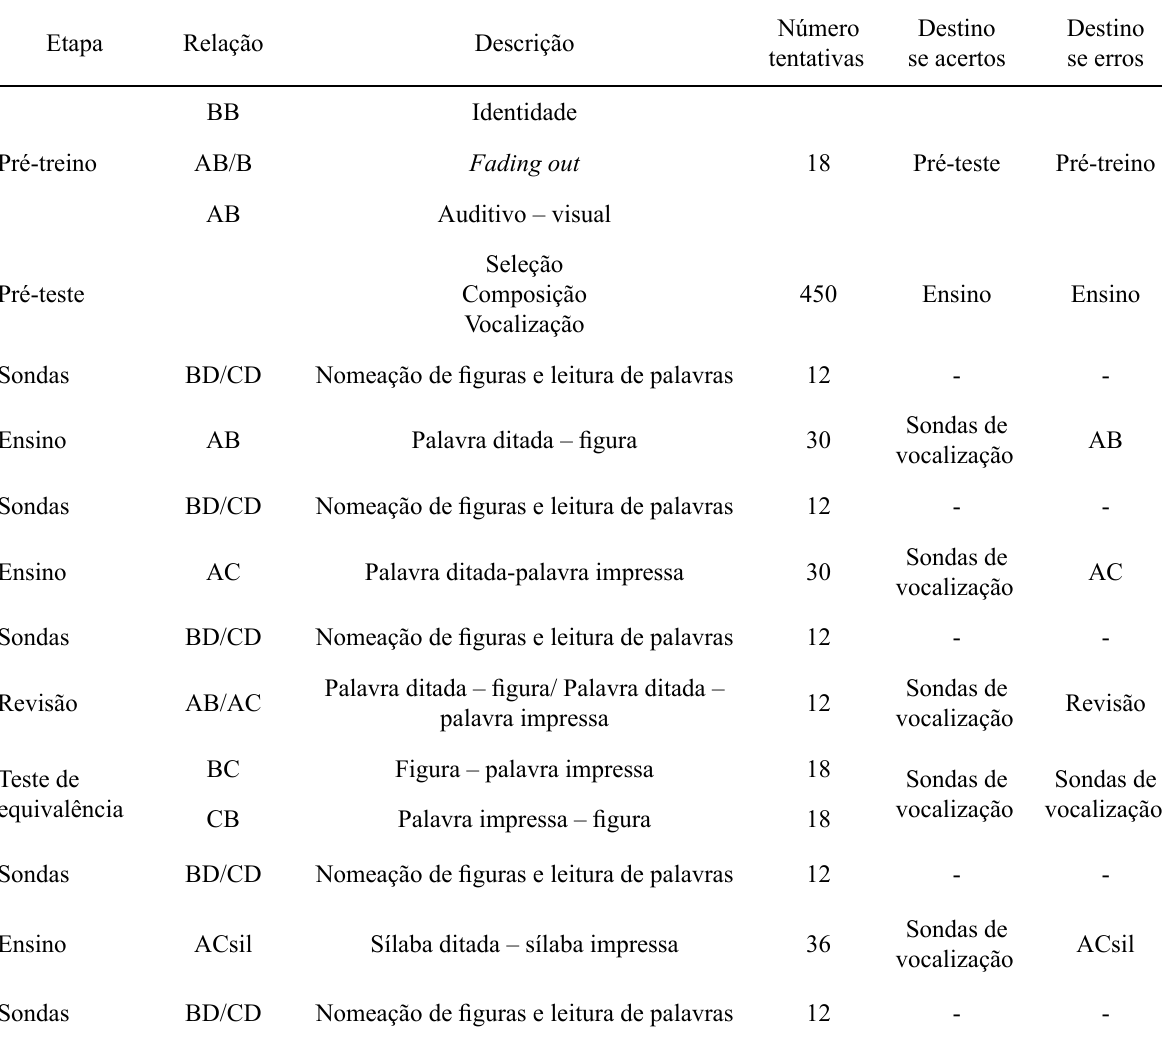
Etapas de Ensino e Sondas: Relações, Descrição, Número de Tentativas, Destino se Acertos ou